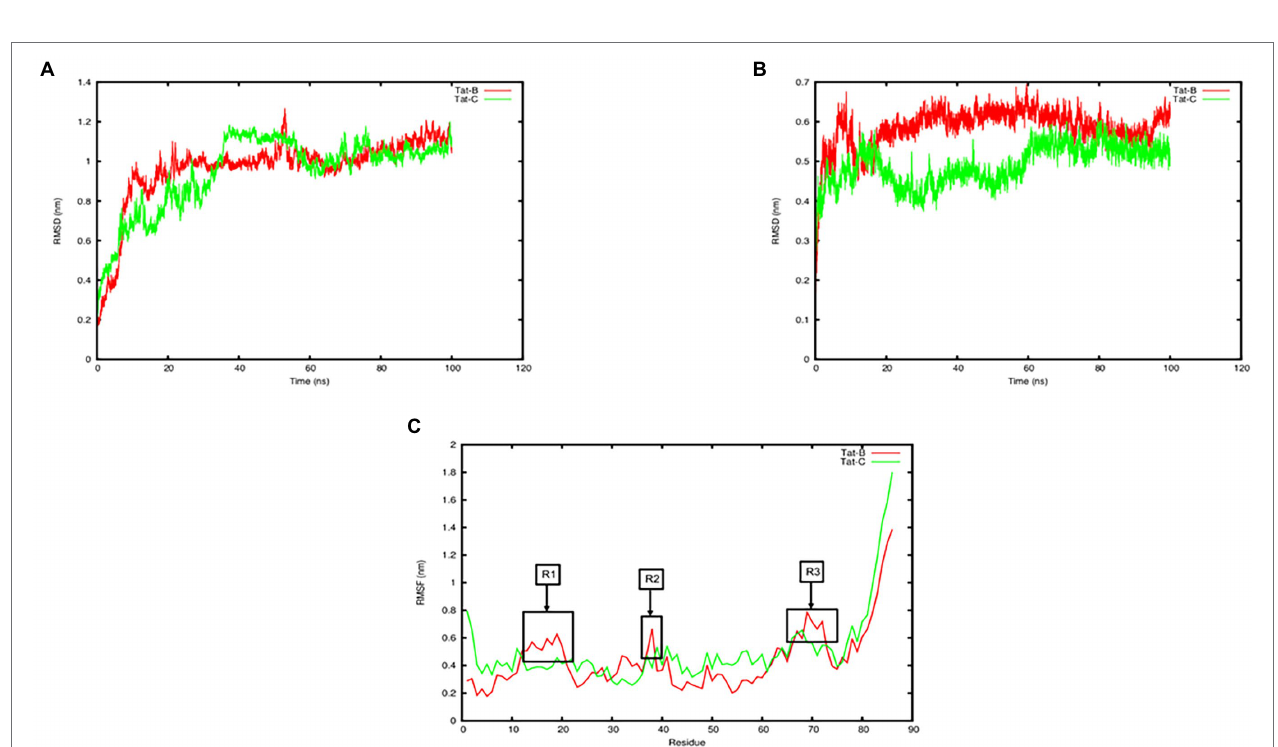
FIGURE 3 | The top predicted binding pose for TAR docked to Tat subtype B and C. Panel (A) shows TAR bound to Tat subtype B and (B) TAR bound to Tat Subtype C. Molecular docking was carried out with the basic region of Tat (cartoon structure) with the bulge region of TAR (grey). Tat is presented as a coiled cartoon structure, with domains represented including the proline-rich region (magenta), cysteine-rich (cyan), core (orange), arginine-rich (red), glutamine-rich (green), and the RGD domain (yellow). Interacting residues are presented as the single letter code. The interacting nucleotides are presented in Table 2 .